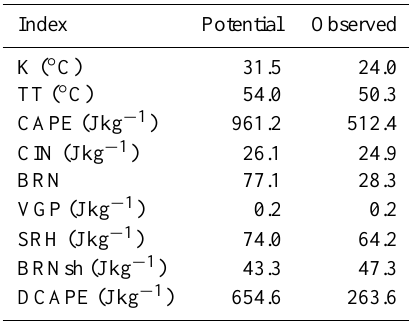
Table 1. Average index values for the potentially and observed ex- treme weather cases.